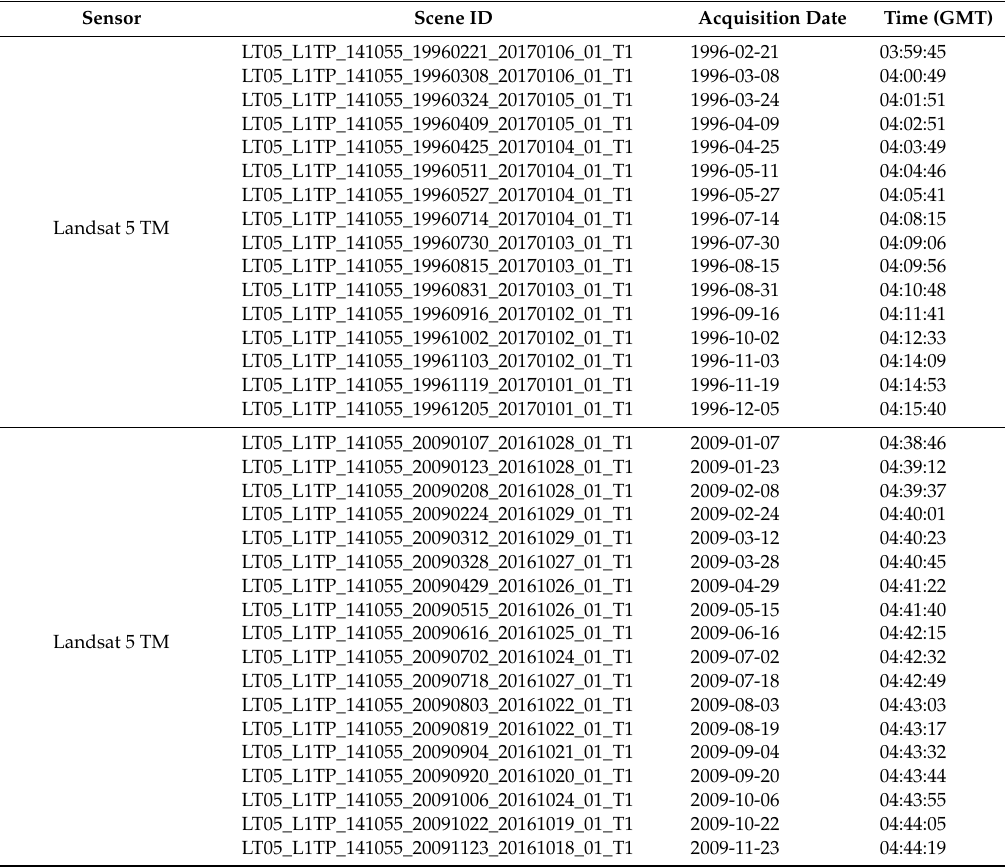
Table A1. Properties of the Landsat images (Level 2) used in this